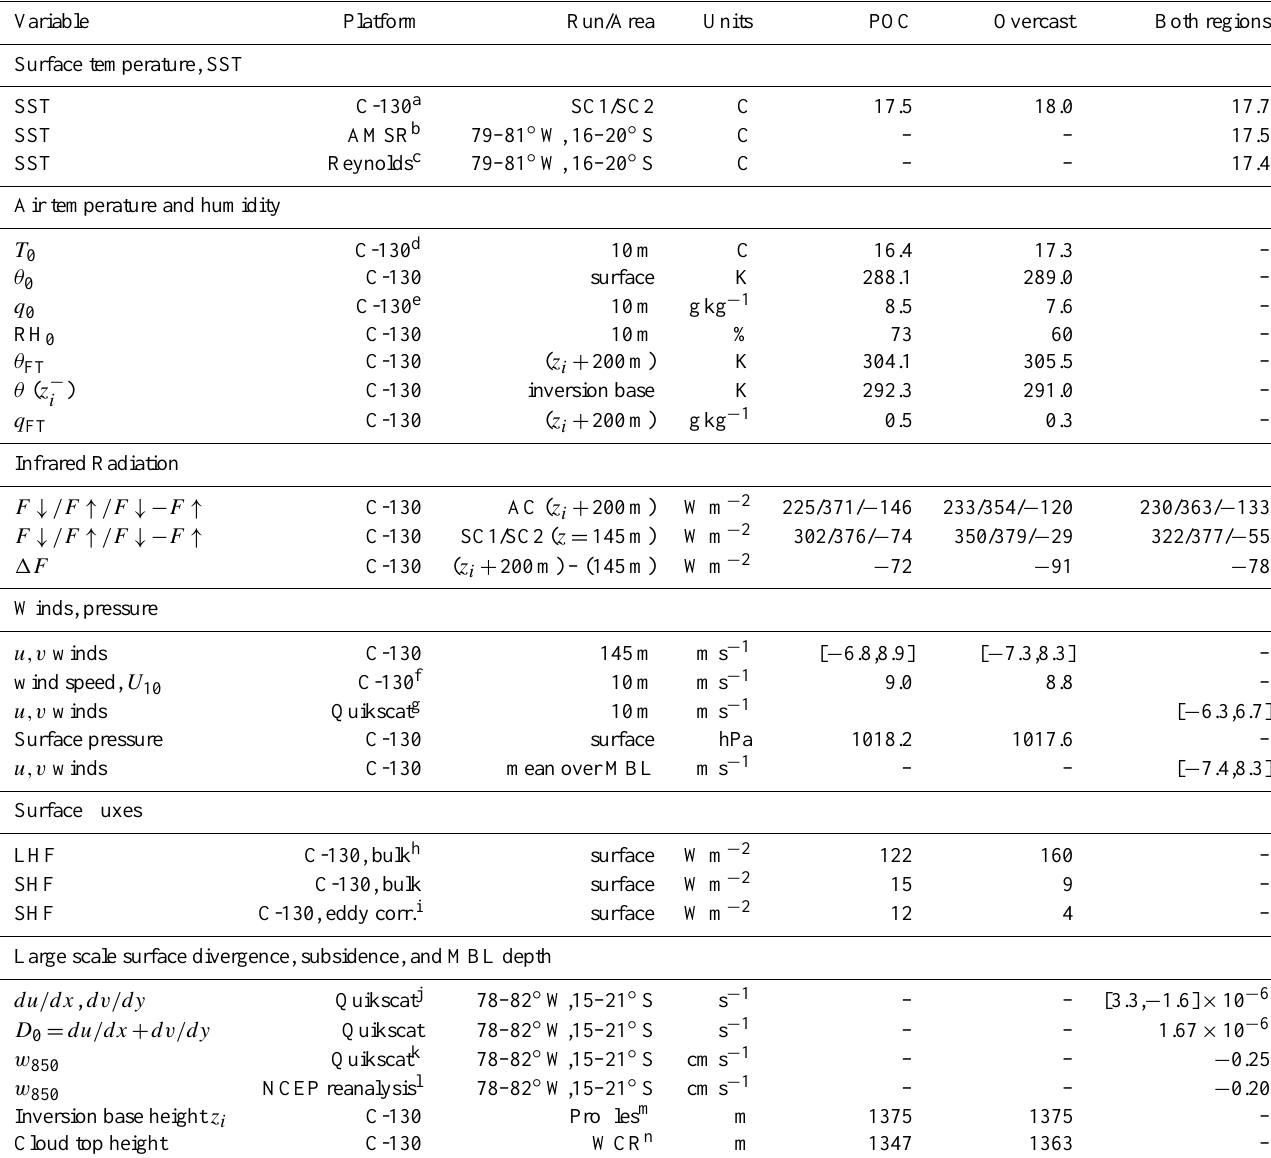
Table 4. Large scale and forcing conditions during C-130 Flight RF06. For some variables, values are given separately for POC and overcast, while for some only an average over a broader region is